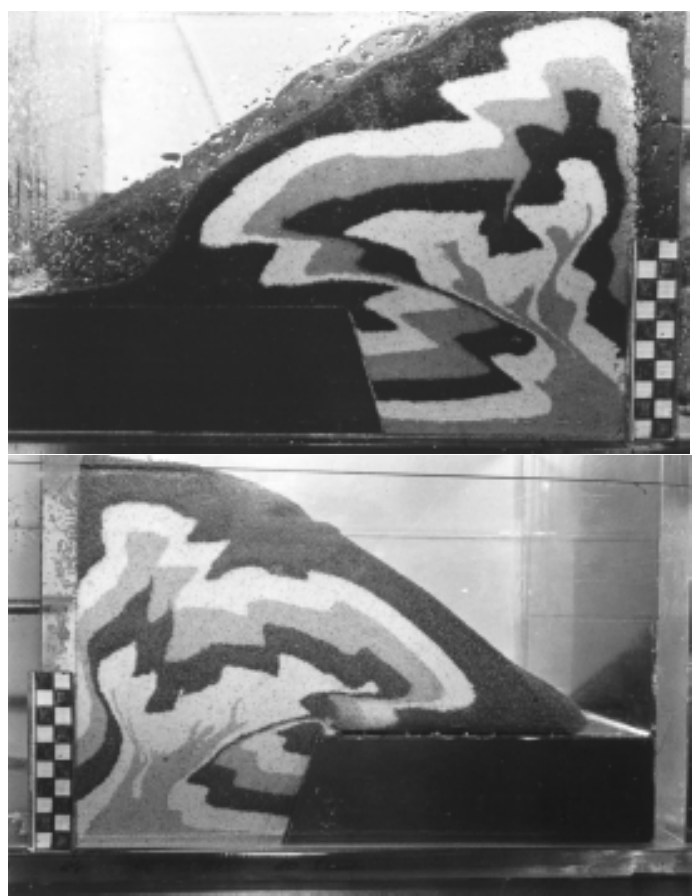
Fig. 6 – Two opposite side wall sections of the same experiment (model M2-a), after 80% shortening, revealing slightly different geometries in the antiformal stack (see text). Scale bar is 5